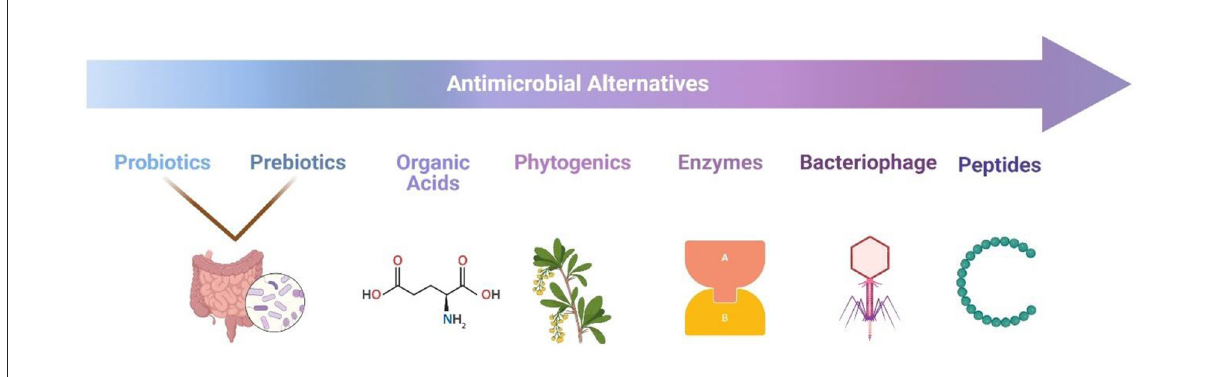
FIGURE1 Various options for antimicrobial alternatives that are normally available all over the